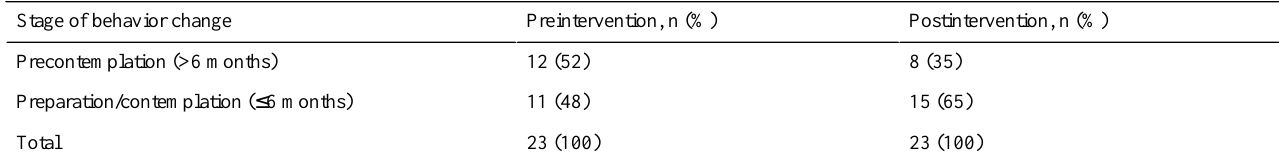
Table 4. Intention to screen by stage of behavior change before and after using ScreenMen